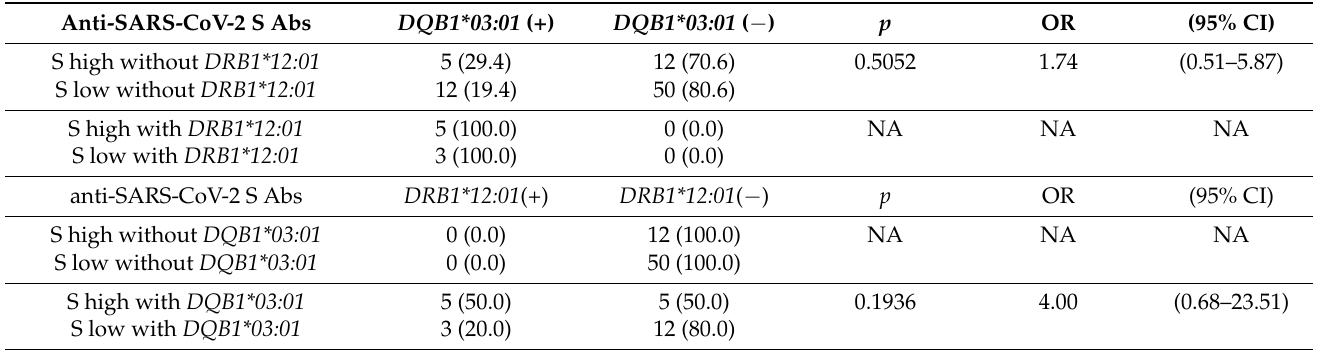
Table 4. DRB1*12:01 and DQB1*03:01 carrier frequencies in RA patients with or without DRB1*12:01 or DQB1*03:01 : associations with anti-SARS-CoV-2 S Abs.